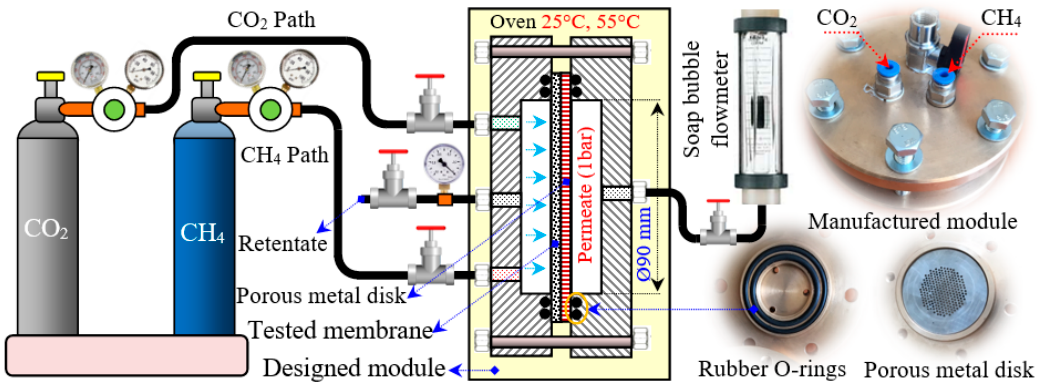
Figure 4. Scheme of the test rig used to perform gases permeation test. Table 1. Definition of the e ff ective parameters of CO 2 and CH 4 permeability. Parameter Definition Unit